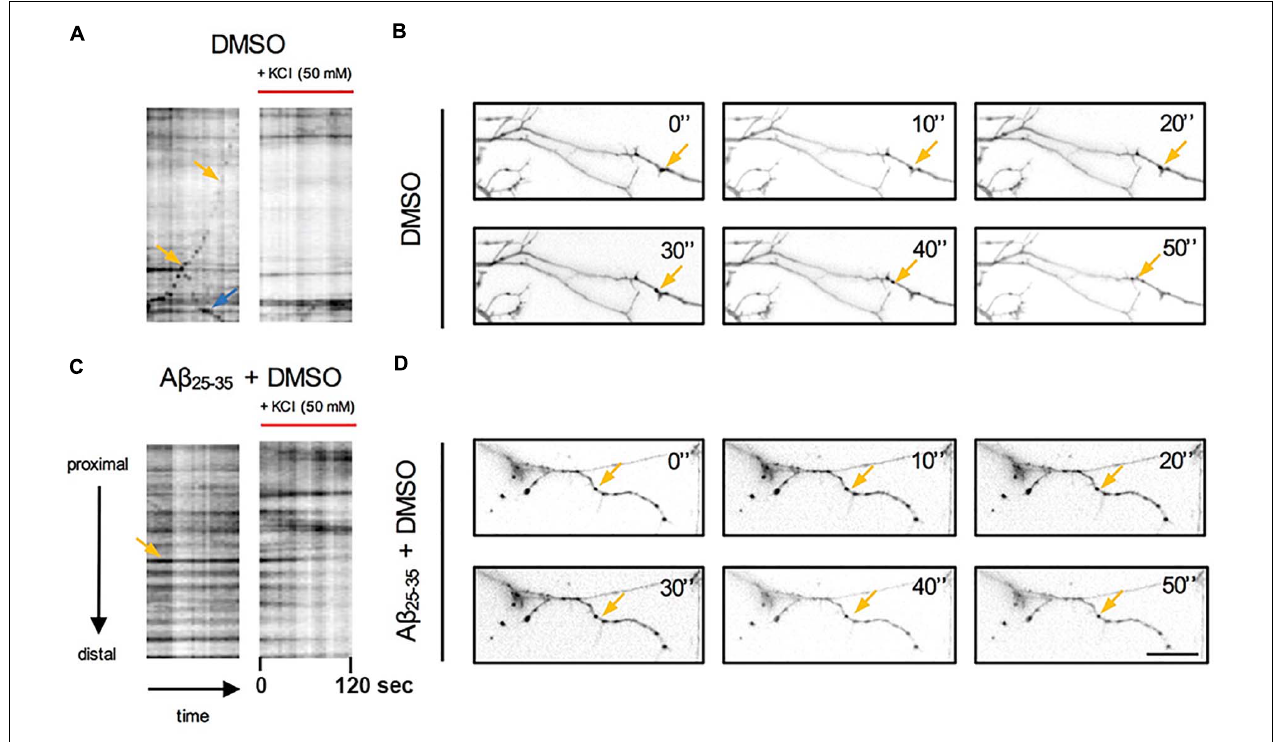
FIGURE 3 | Qualitative analysis of the effects of A β and KCl-induced neuronal activity on pGOLT spots trafficking. Kymograph representation of (A) pGOLT spots trafficking (2 min) in hippocampal neurons in control (DMSO) or (C) A β treatment (10 µ M, 4 h) in basal and KCl conditions (50 mM, 2 min). (B) Representative images of neuronal dendrites in control and (D) A β + DMSO (bottom) in basal conditions. (A,B) In control conditions, retrogradely (yellow arrows) and anterogradely (blue arrows) moving pGOLT spots were detected. (C,D) In A β -treated cultures, static pGOLT spots (yellow arrows) were mostly detected. Images are acquired for 2 min with 5 s interval. Scale bar = 15 µ